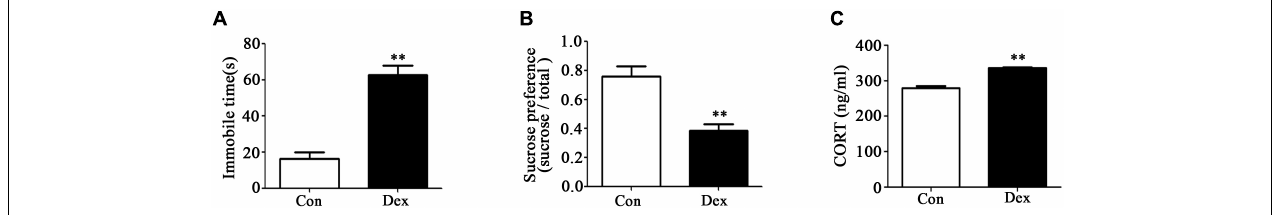
FIGURE 1 | Prenatal Dex exposure induces depression-like behavior and increases circulatory GC level in adult offspring. Pregnant rats were administered Dex at 0.1 mg/kg/d during GD14 to 21. Behavioral tests and determination of corticosterone concentration in blood were performed on male offspring rats at adult (9-week old). Immobile time of FST (A) ; sucrose preference test (B) ; corticosterone level (C) . Data are presented as means ± SEM ( n = 10). ∗∗ P < 0.01 vs. control. Con, control; Dex,